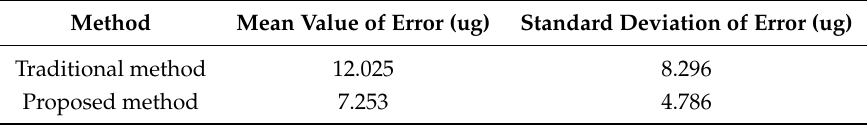
Table 5. 36 position error